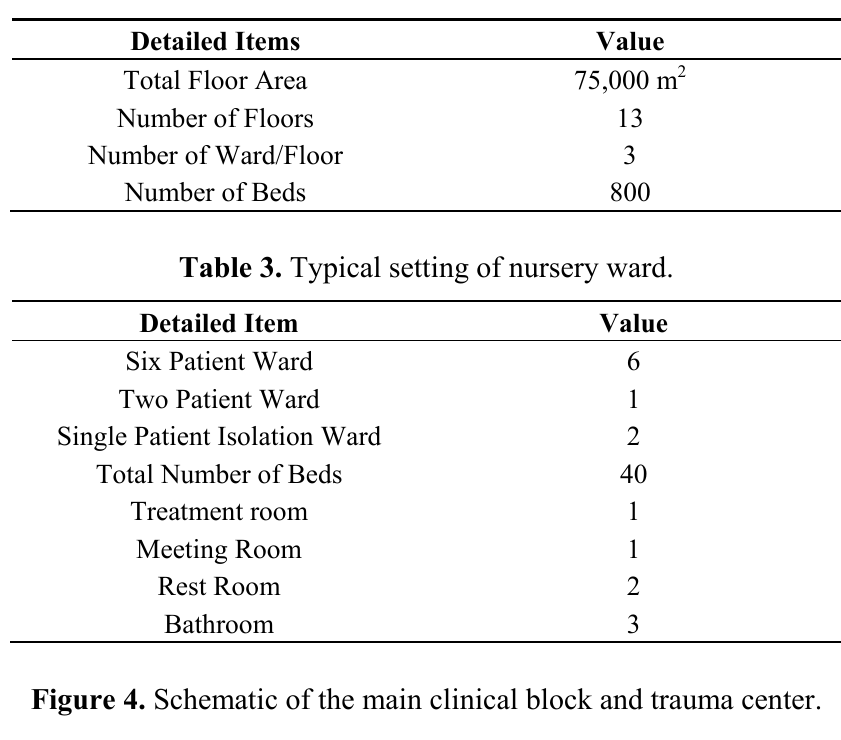
Table 2. The details of the main clinical block and trauma center.